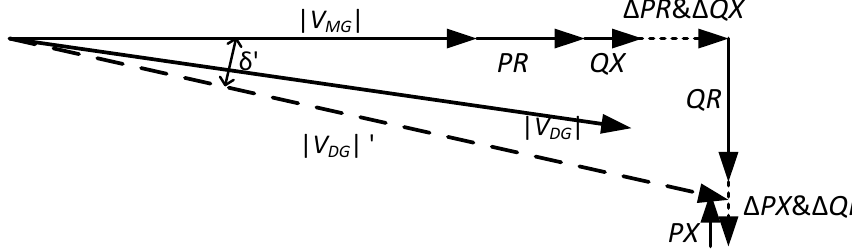
Figure 3. Phasor diagram of voltages in islanding condition by changes in P and Q .